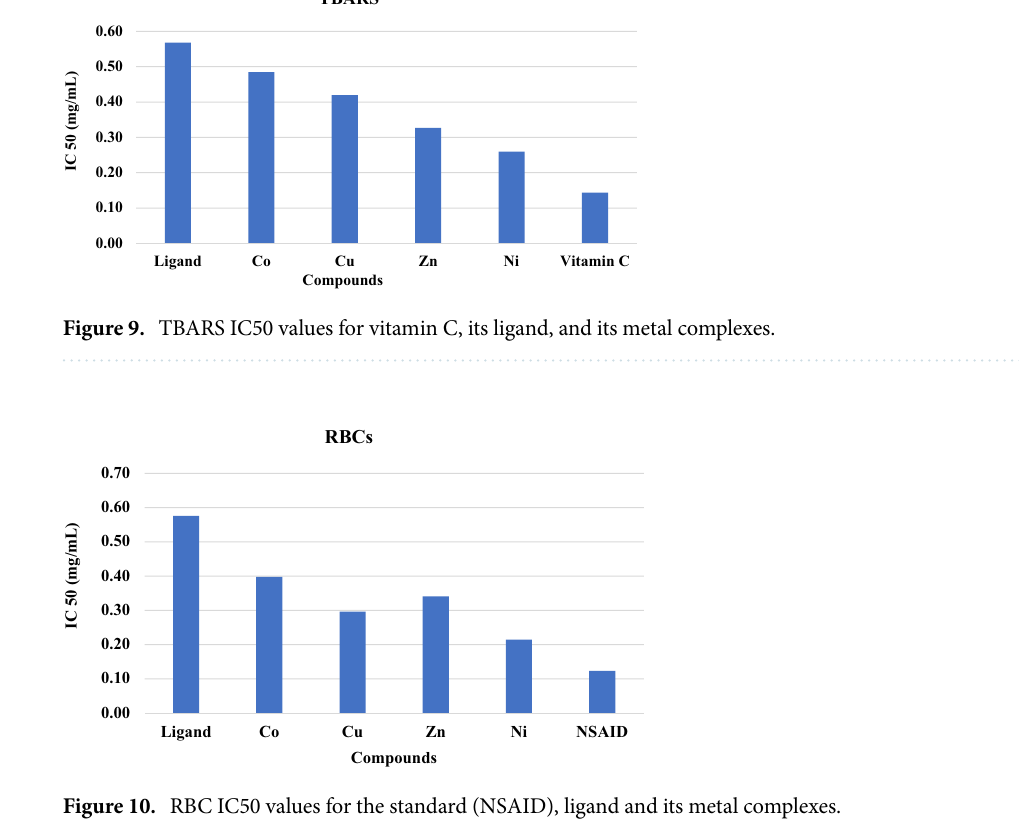
Figure 10. RBC IC50 values for the standard (NSAID), ligand and its metal